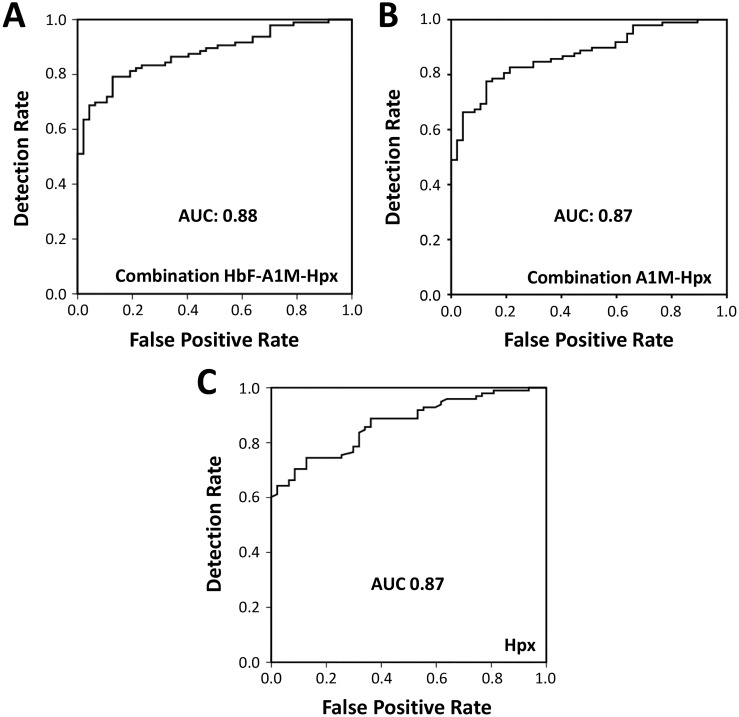
Receiver operating characteristic (ROC) curves.ROC curves showing sensitivity and specificity for the combination of HbF, A1M and Hpx (A), Hpx and A1M (B) and Hpx (C). Area under curve (AUC) is 0.88 for the combination of HbF, A1M and Hpx, 0.92 for the combination of A1M and Hpx and 0.87 for Hpx.